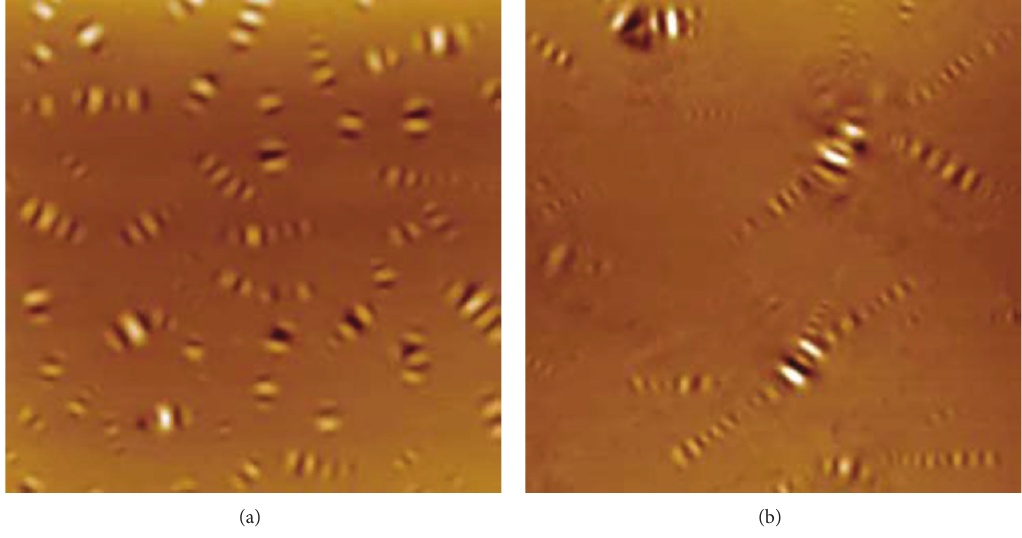
Figure 8: Topographic AFM images of two types of asphalt [52].